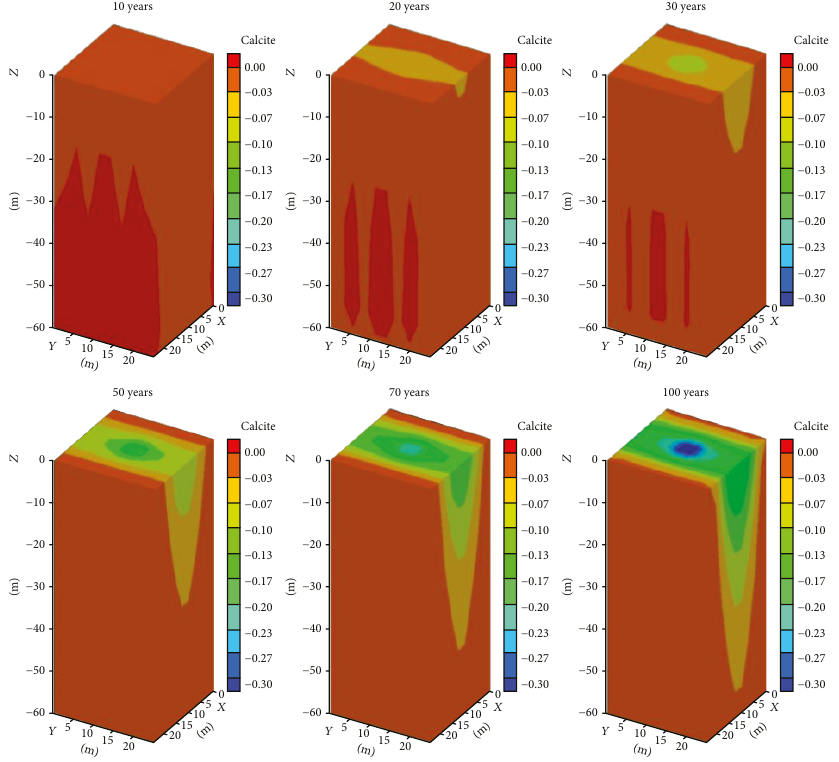
Figure 10: The corrosion range of the fi ssure under medium hydrodynamic conditions-low permeability — 20 °